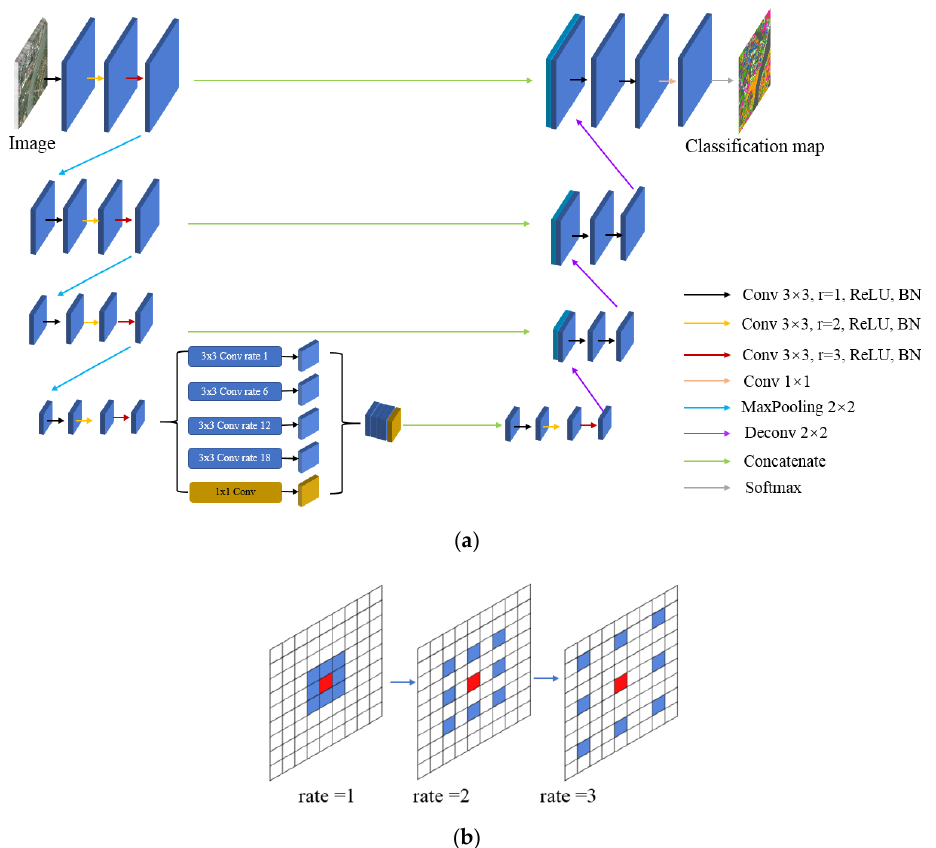
Figure 1. Our FACNN structure for land use segmentation. Multi-rate Atrous convolution is introduced into each scale of the encoder, and in the highest scale an ASPP is added ( a ). ( b ) shows the different rates of sequential Atrous convolution where red pixel is the kernel center and blue and red consist of a kernel. The white pixels are skipped.